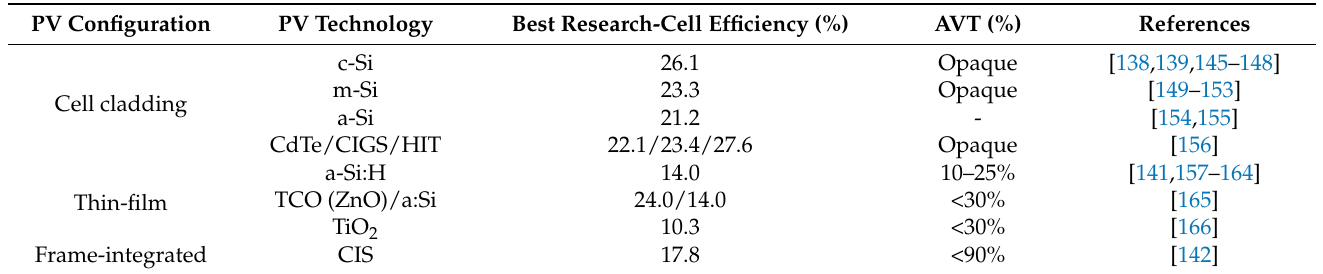
PV technology used in each study (c-Si—mono-crystalline; m-Si—multi-crystalline; a-Si—amorphous silicon; a-Si:H—hydrogenated amorphous silicon; CdTe—cadmium telluride; CI(G)S—cooper indium (gallium)selenide; HIT—heterojunction intrinsic thin layer; TCO—transparent conducting oxide; ZnO—zinc oxide; TiO 2 —titanium